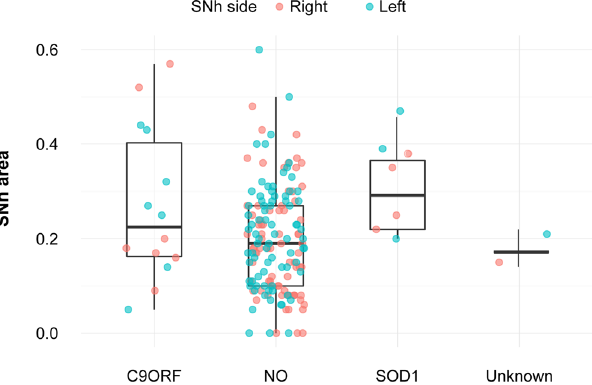
Figure 2. SNh area on the left and the right side in sporadic or familial ALS patients harbouring mutations (“C9ORF72” and “SOD1”), familial ALS without known mutations (“Unknown”) and sporadic patients not carrying mutations (“NO”). SNh: hyperechogenicity of the substantia nigra.